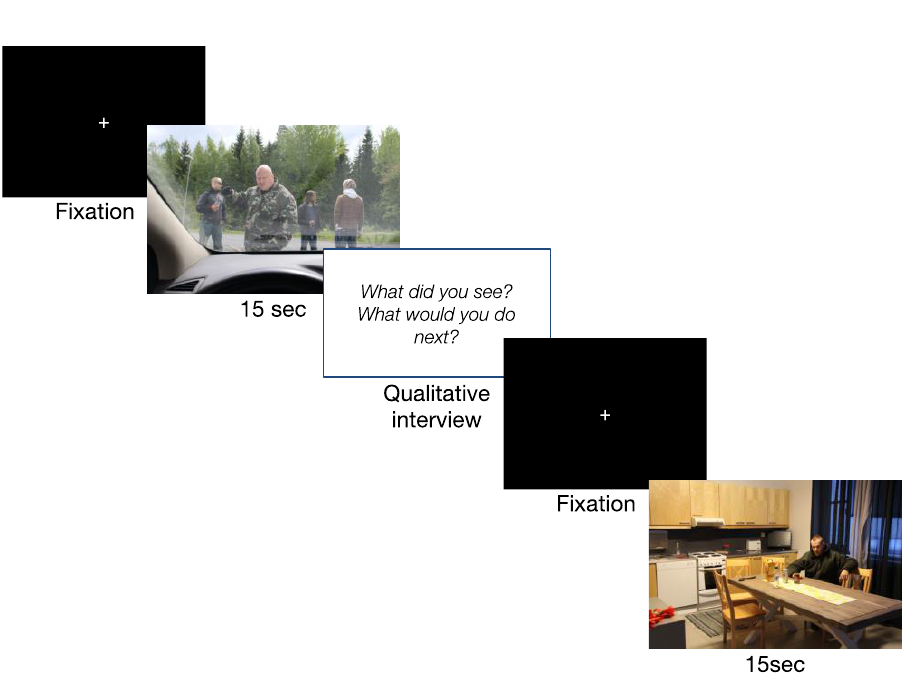
Figure 1. Experimental procedure. Note that interview questions following each image were the same and were not presented on the computer screen. Qualitative analyses of interview data will be presented in a separate study.